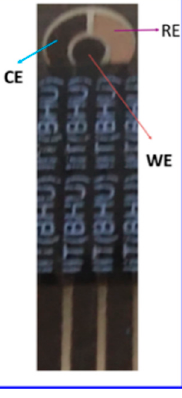
Figure 1. Homemade screen-printed electrode (WE = working electrode, RE = reference electrode and CE = counter electrode). and CE = counter